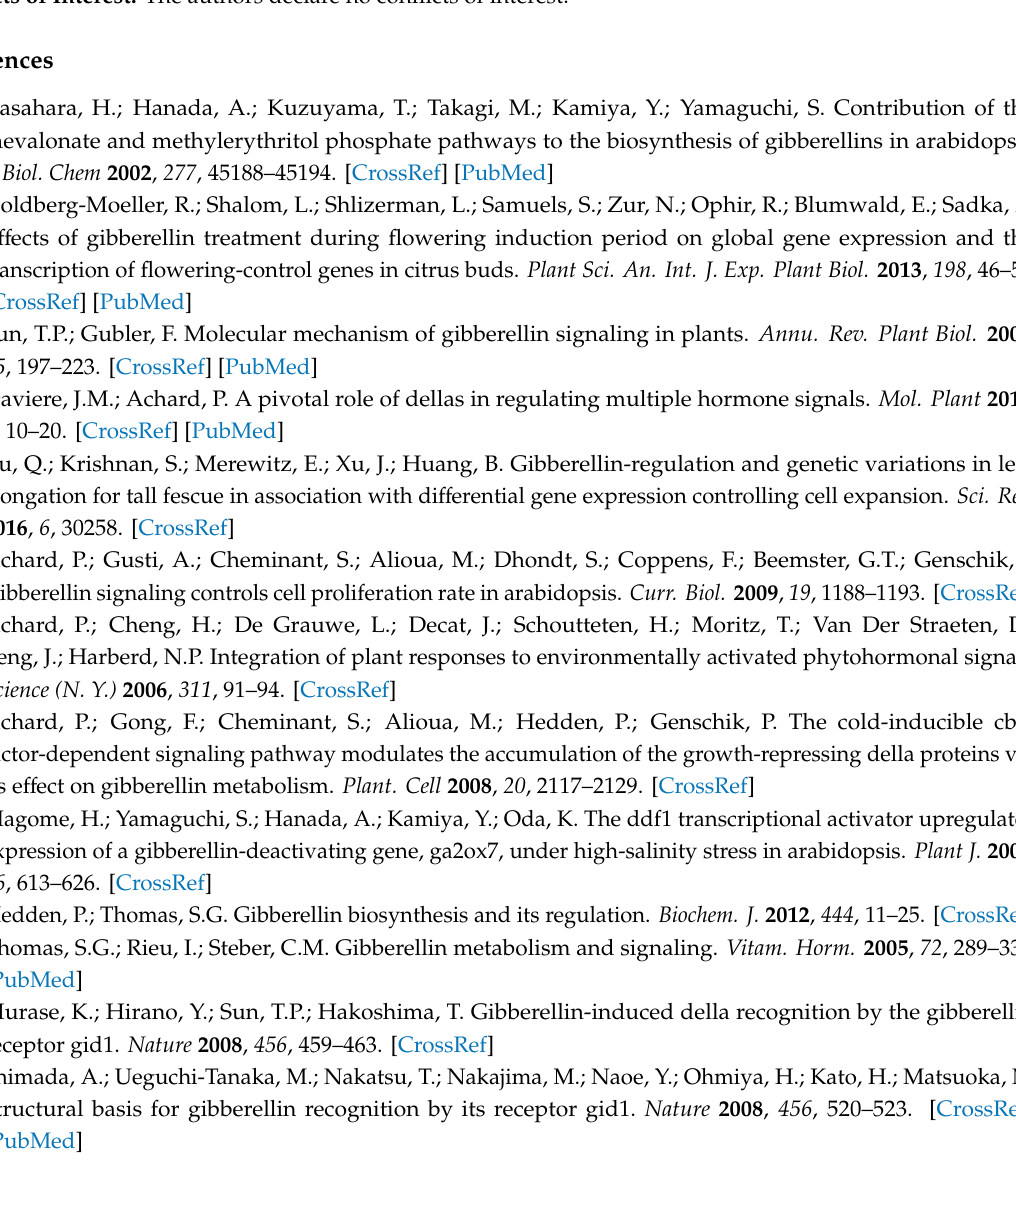
Figure S1: The qPCR analysis of flowering time DEGs in response to GA between the two inbred lines. Figure S2: Experimental design for RNA-seq analysis. Figure S3: DEGs’ analysis by gibberellin treatment on each line. Figure S4: Comparative Kyoto Encyclopedia Genes and Genomes pathways of DEGs in two inbred lines under gibberellin treatment. Figure S5: RNA-seq validation of flowering time genes. Table S1: Cleaned short reads statistics after trimming of RNA sequencing data. Table S2: Statistics of reads mapping to Theragen Bio Institute (TBI)—unigenes. Table S3: Radish homologs of GA-specific genes. Table S4: Flowering time-specific DEGs on GA treatment. Table S5: Gibberellin-specific DEGs on GA treatment. Table S6: Gene-specific primer information for qPCR